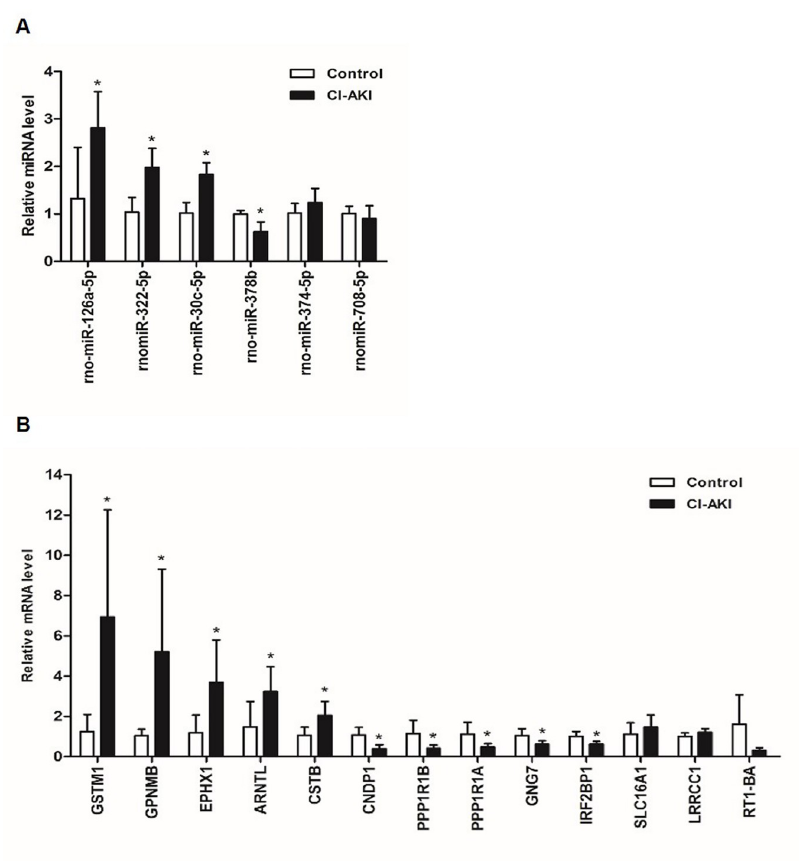
data. N = 6 per group, � P < 0.05 vs. control group.